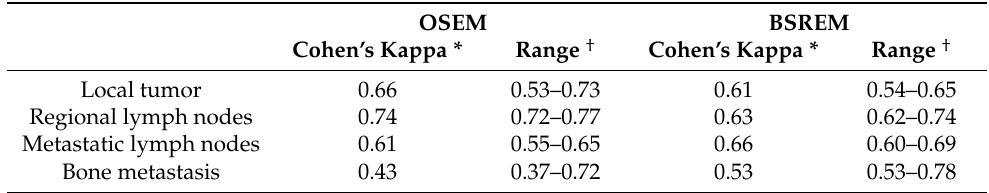
Table 3. The inter-rater agreement of the lesions per group findings depending on the reconstruction